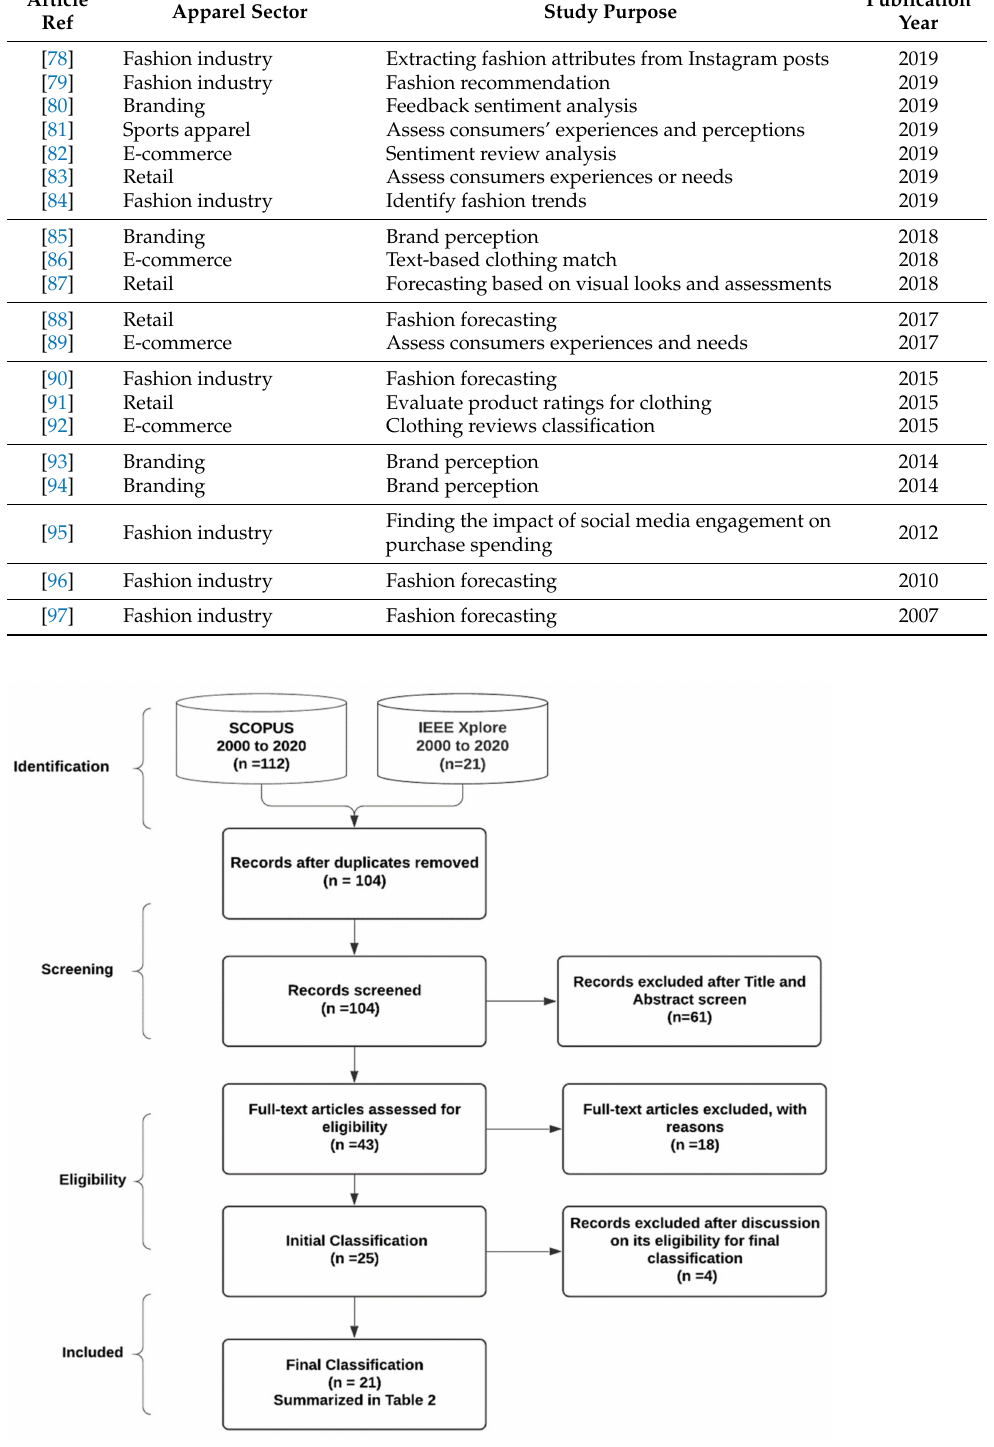
Figure 4. Phase II: Text Mining and Supply Chain Risk Management research papers selection